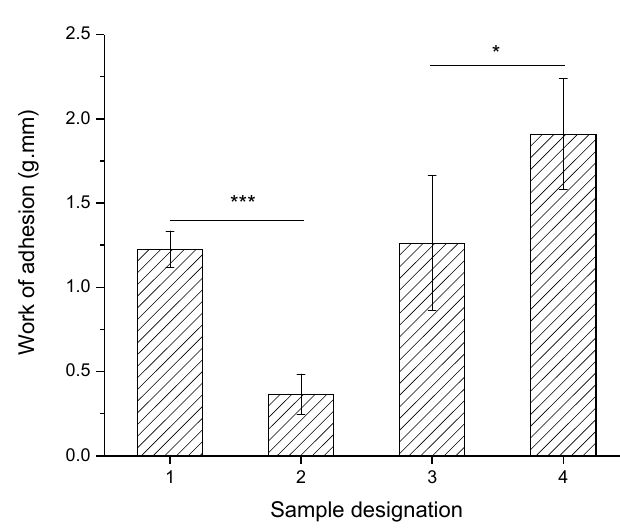
Figure 5. Work of adhesion of Ch / P fibers with pig small intestine, normalized with Teflon pads as a control. Results are expressed as means ± standard deviation, and are performed in triplicates, p < 0.05 (*) and p < 0.001 (***).